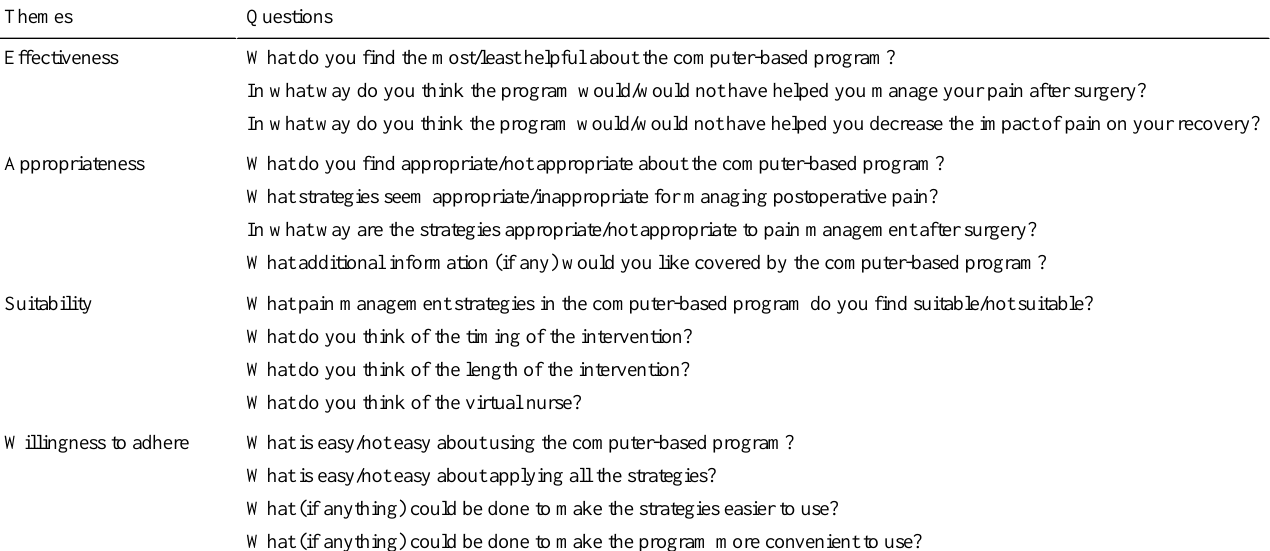
Table 2. Semistructured interview guide adapted from the TAP measure